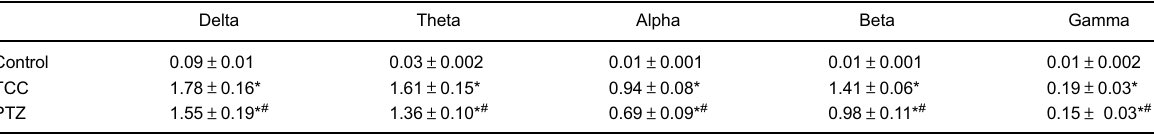
Figure 2. Electrocorticographic recordings of ( A ) control group, ( B ) TCC group, and ( C ) PTZ group. D , Representation of the linear frequency distribution between groups with frequency up to 50 Hz. E , Representation of the total power linear distribution of cerebral activity. Data are reported as means ± SD (n=7 animals/group). *P o 0.05 and ****P o 0.0001 (one-way ANOVA followed by Tukey ’ s test). TCC: thiocolchicoside; PTZ: pentylenetetrazole. Table 1. Relative bandpower of brainwaves measured in mV 2 /Hz (cid:1) 10 – 3